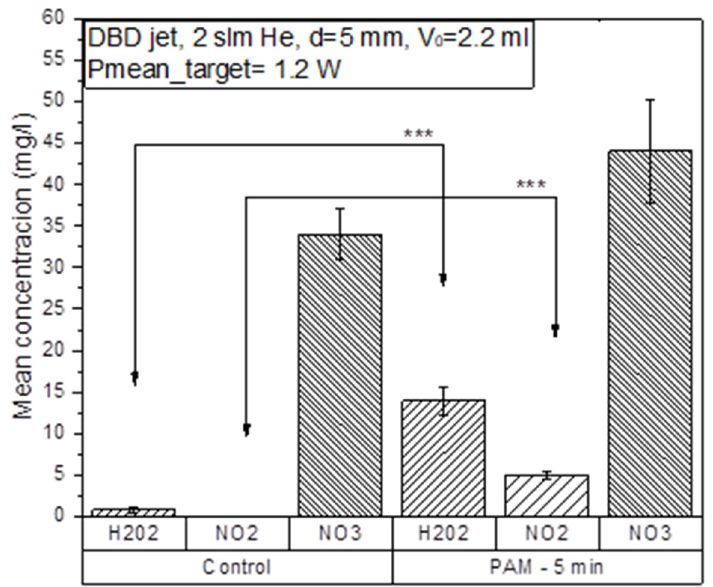
Figure 2. Measured concentrations of RONS in the plasma-activated medium PAM- RPMI 1640 compared to concentrations in the untreated RPMI 1640 medium. Helium flow during the treatments was kept constant at 2 slm and the power deposited in the discharge in contact with the sample was 1.2 W. The distance between the edge of the APPJ and the sample surface was 5 mm in all treatments. *** p < 0.005 compared to non-treated control RPMI 1640 (0% PAM) or as indicated by line.